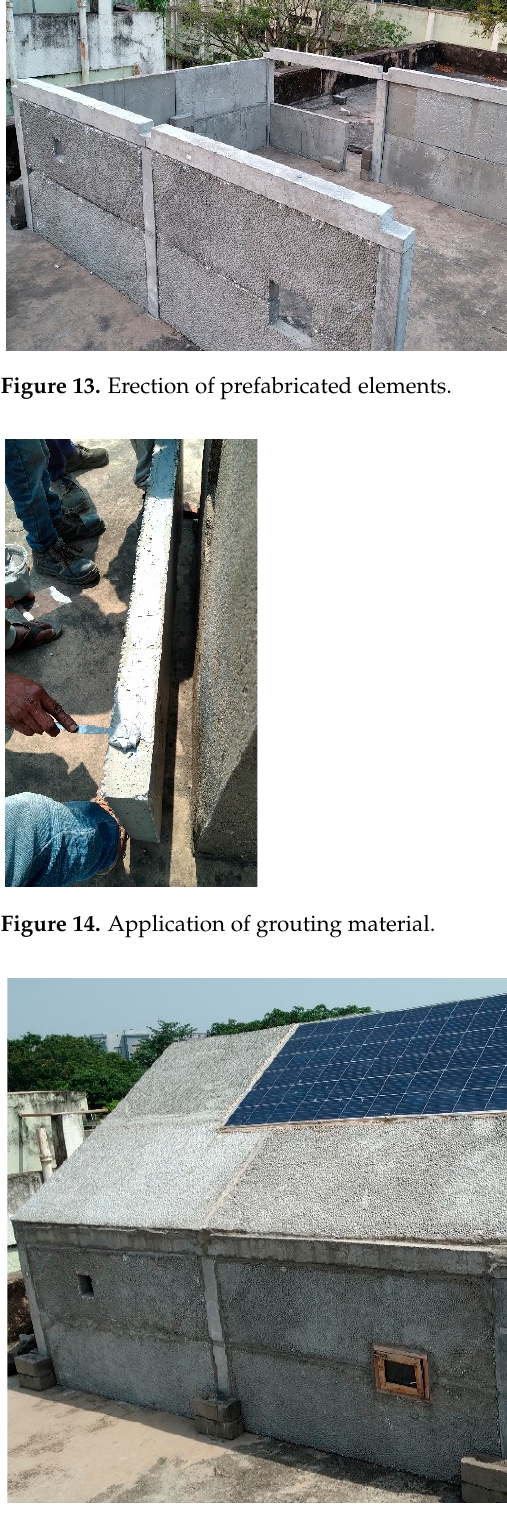
Figure 15. Small-scale prefabricated model.